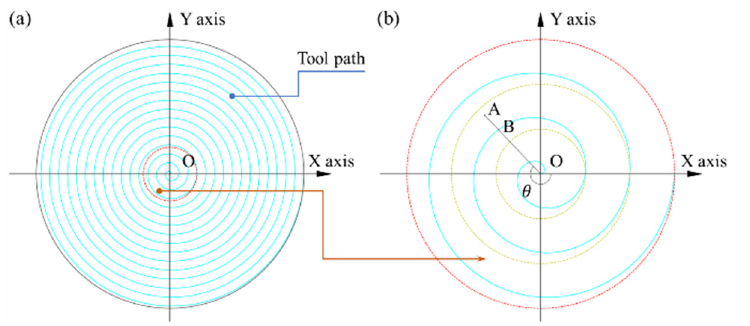
Figure 8. ( a ) Diamond tool path of SPDT(Pre) relative to the surface of the workpiece; ( b ) five-x local magnification view.